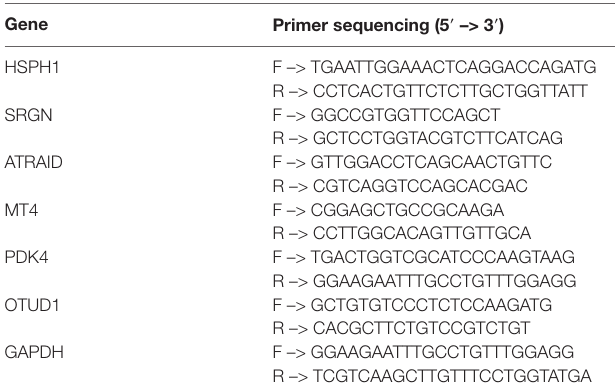
TABLE 1 | List of primers used for qRT-PCR validation of RNA-Seq